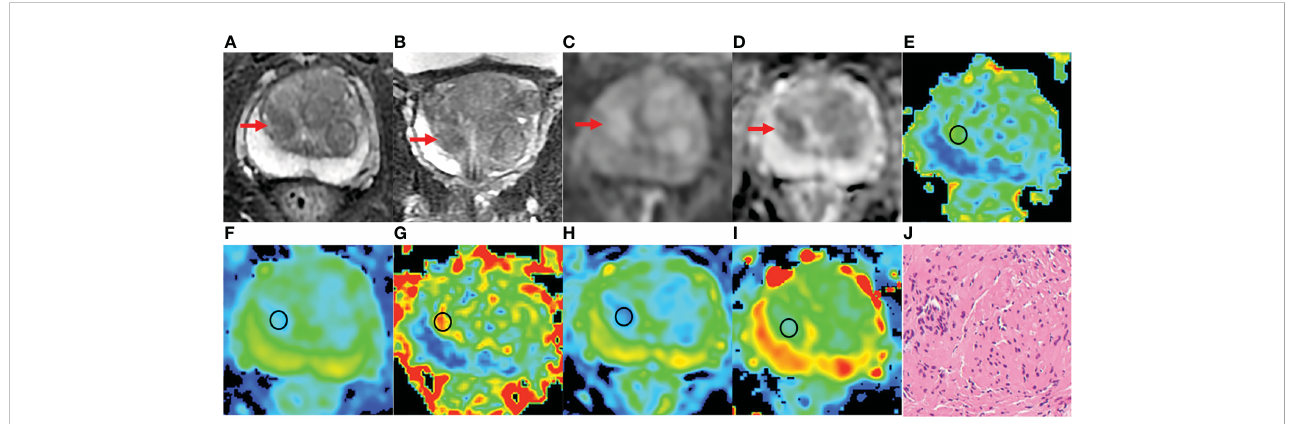
FIGURE 5 An 81 years old man with PCa, PSA of 6.47 ng/ml, and Gleason 3 + 3. (A-D) The lesion with PI-RADS 3 seen in the right middle transition zone. (E) Fractional anisotropy (FA) of 0.257. (F) Mean diffusion (MD) of 1.018×10 -3 mm 2 /s. (G) Mean kurtosis (MK) of 0.754. (H) Diffusion coef fi cient (D) of 0.588×10 -3 mm 2 /s. (I) Distribute diffusion coef fi cient (DDC) of 0.717×10 -3 mm 2 /s. (J) HE staining,